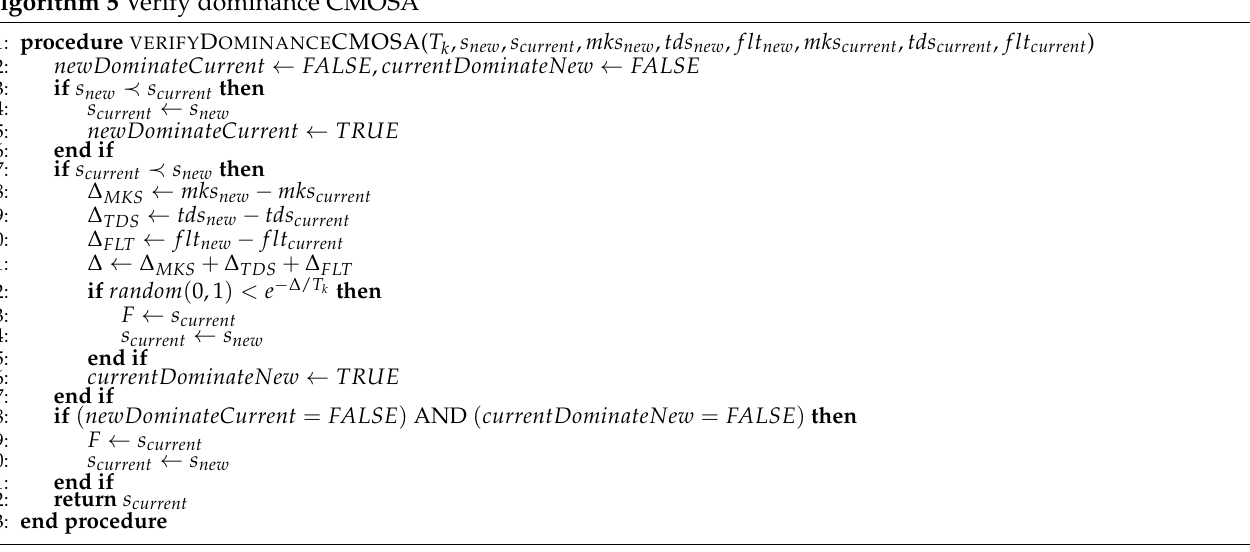
Algorithm 5 Verify dominance